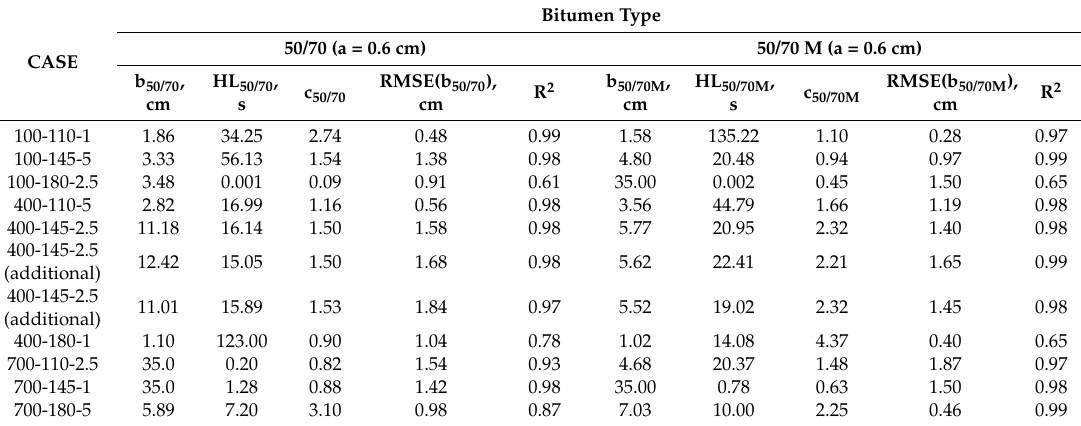
Table 4. Distribution of foaming